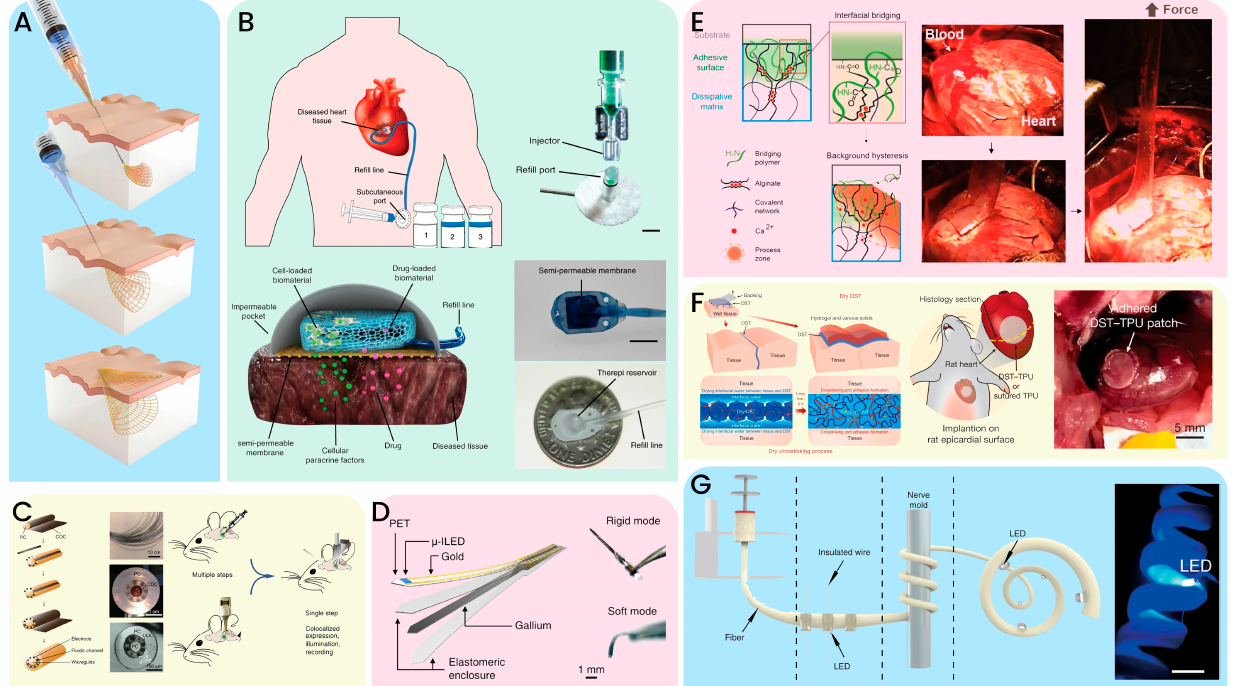
Figure 3. Minimally invasive surgery (MIS) approaches. ( A ) Electronics injected via syringes. Re- produced with permission from ref. [25]. ©2015 Nature. ( B ) Tube-based tissue delivery via MIS. Reproduced with permission from ref. [28]. ©2018 Nature. ( C ) MIS functional fi ber for optogenetics. Reproduced with permission from ref. [31]. ©2017 Nature. ( D ) Transformable electronic implanta- ble sensor [12]. ( E ) Tough adhesion formation on a wet surface and hydrogel-based tough adhesive mounting on a heart. Reproduced with permission from ref. [37]. ©2017 AAAS. ( F ) Tough adhesion formation between tissue and dry double-sided tape and its mounting on a heart. Reproduced with